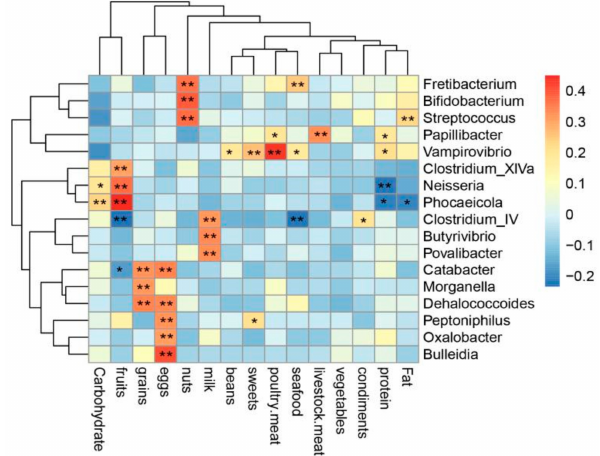
Figure 6. Correlation of genus with dietary intake (* p < 0.05, ** p < 0.01; p value was calculated using Pearson’s